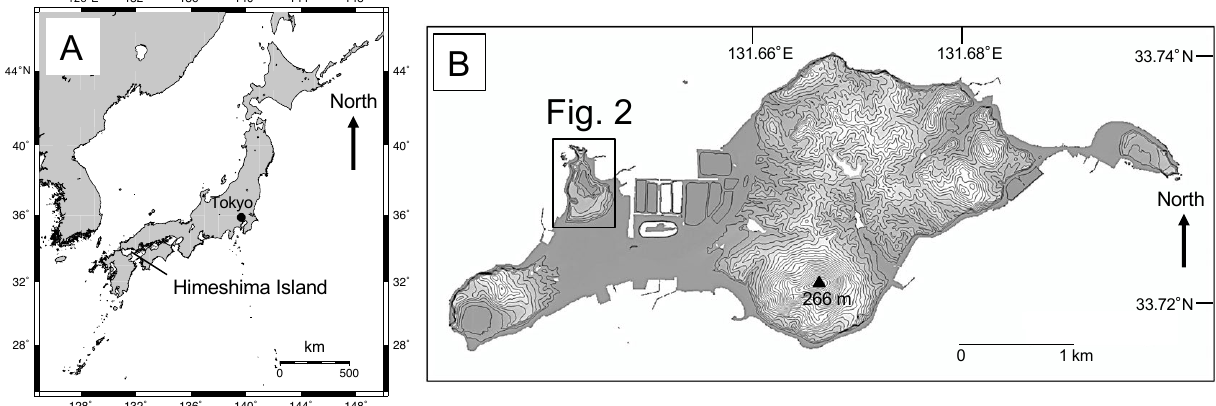
Figure 1: [A] Map of Japan and the adjacent area. [B] Topographic map of Himeshima Island.